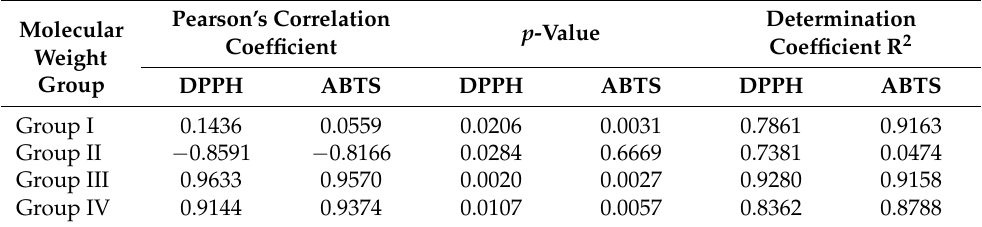
Table 4. The correlation coefficients between the amount of the four protein groups and the total radical scavenging activity of the water extracts of bivalve tissue.